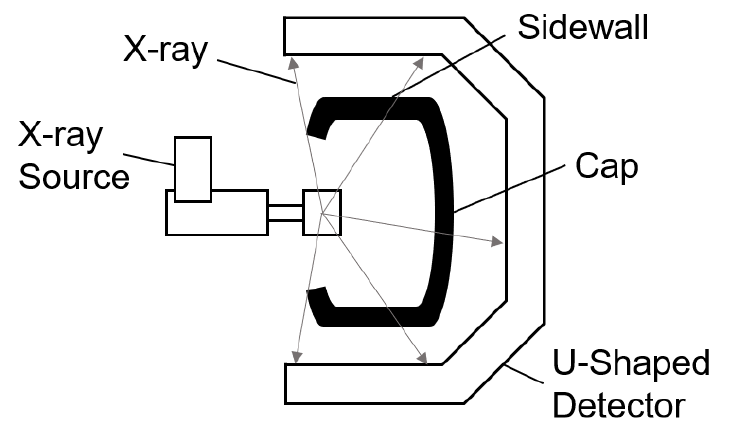
Figure 1. How the imaging equipment works.